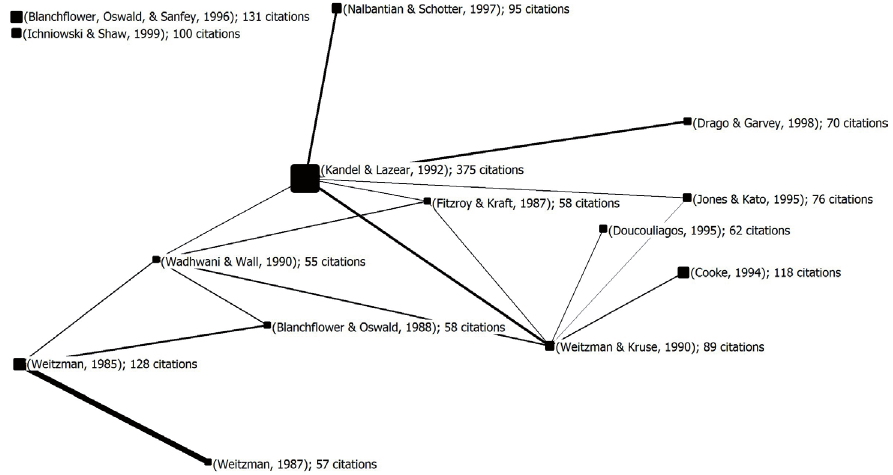
Fig. 1 – Co-citation analysis of articles with more than 50 citations. Source: author’s own. For preparation of Fig. 1 we used software described in (Borgatti, Everett, & Freeman, 2002). Size of nodes (i.e. articles) matches to the number of citations of a given article and thickness of lines between nodes matches to the number of co-citations between a given pair of articles; by visible line are connected articles, which are together cited at least 10